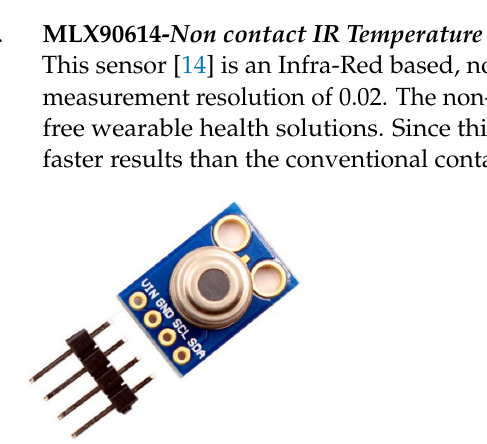
Figure 3. MLX90614 Non-Contact IR Temperature